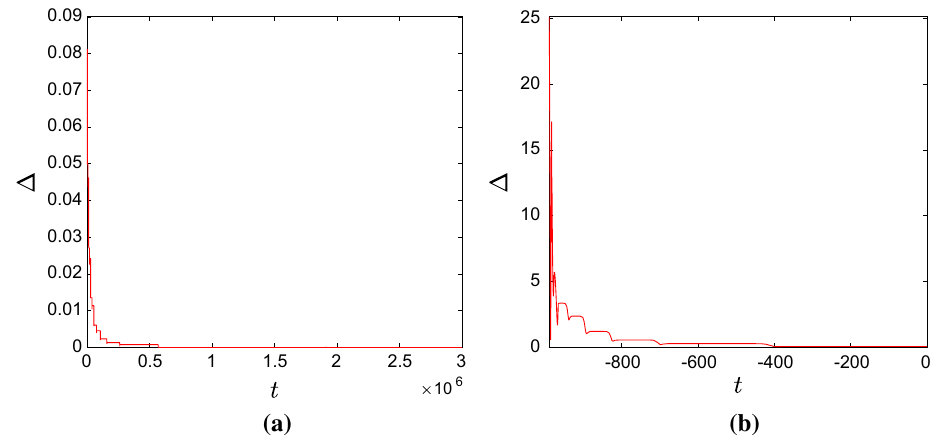
Fig. 4 The difference between the exact and the asymptotic solutions: a evolution towards the singularity, b evolution away from the